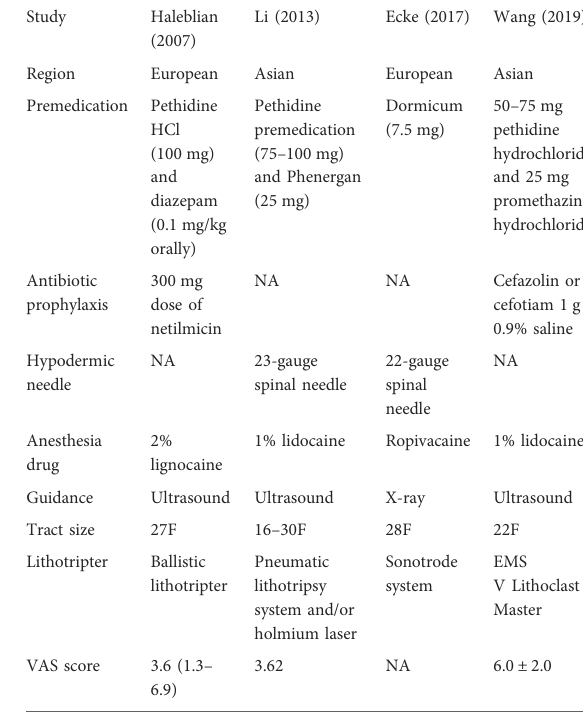
TABLE 4 The characteristics of LA in previous